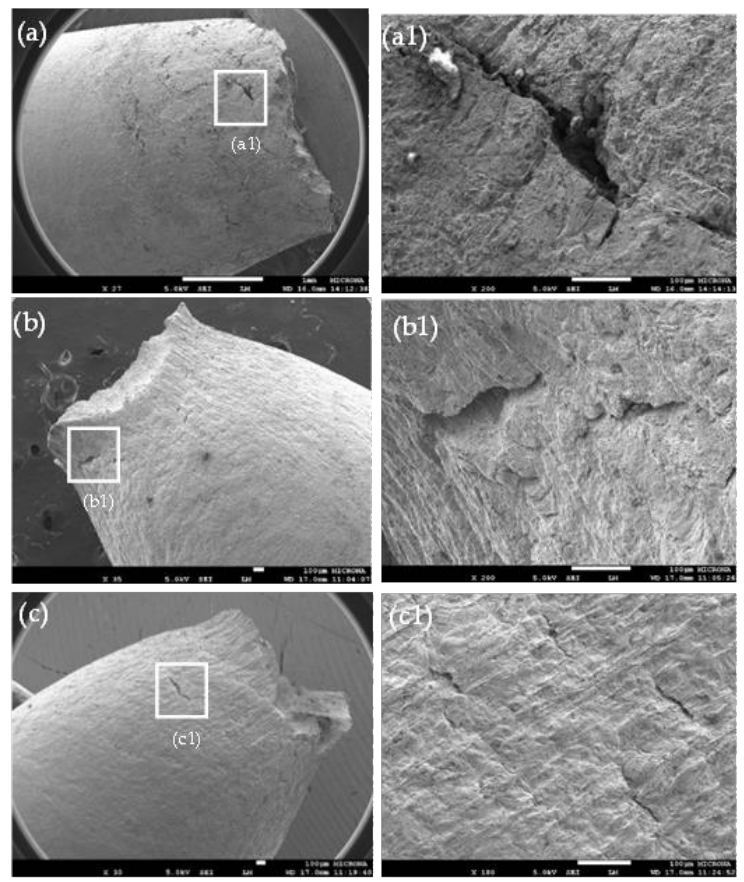
Figure 4. SEM micrographs of side surfaces of X70 steel in the NS4 solution at different pH, ( a , a1 ) pH 3 ( b , b1 ) pH 8 and ( c , c1 ) pH